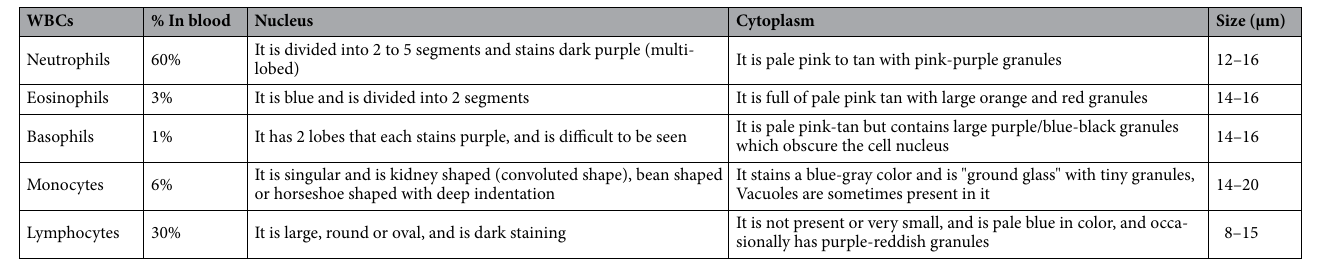
Table 1. Characteristics of white blood cells 4 .